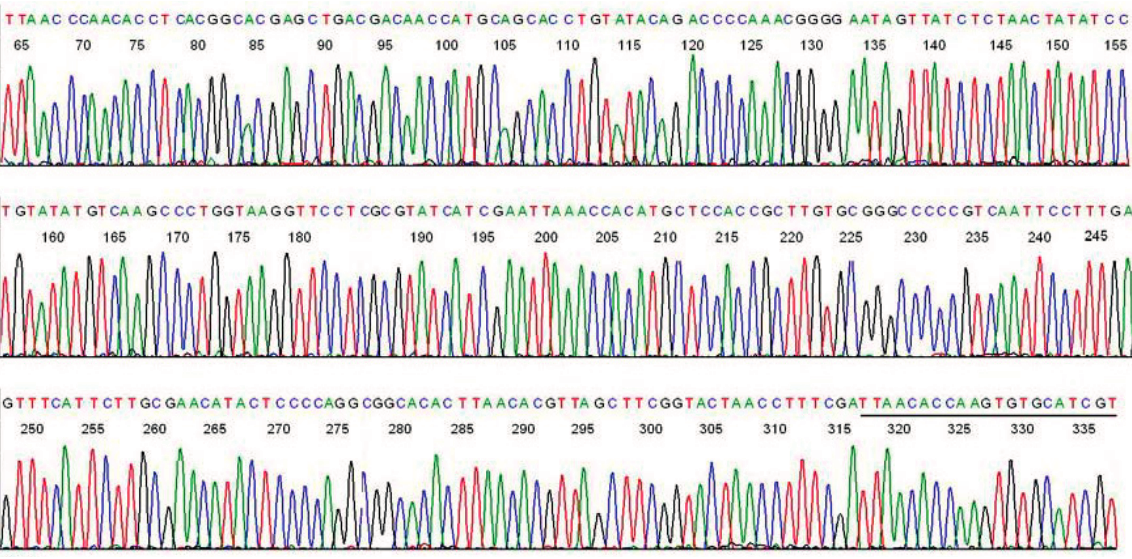
Figure 2. Base-calling sequencing electropherogram of an M1/M2 PCR amplicon showing part of a 358-bp segment of the 16S rDNA of B. miyamotoi in an Ixodes scapularis tick removed from the skin bite of a patient (Figure 1, lane 1). M2 was the sequencing primer. The M1 binding site is